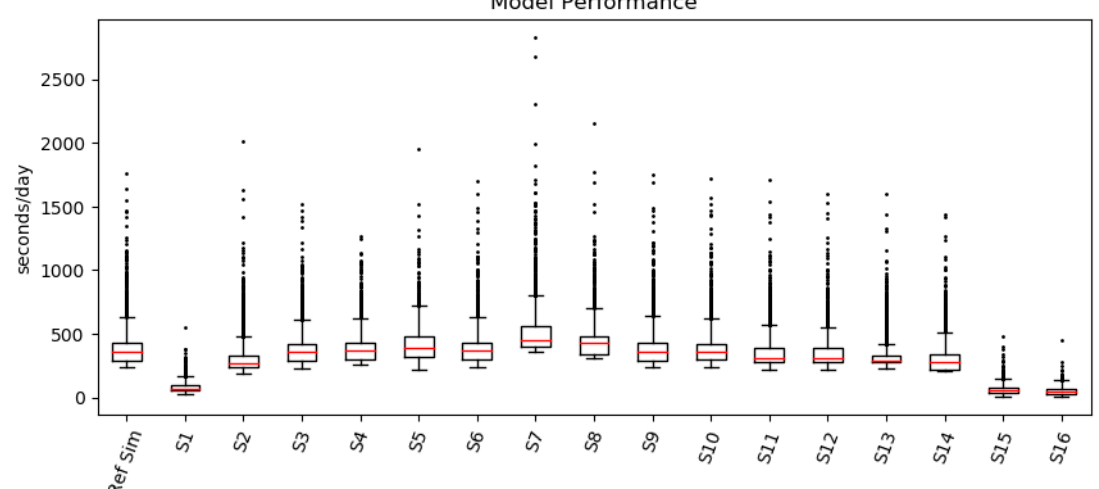
Figure 8. Boxplot graph with the computation time spent for each day of the simulation performed in the sensitivity analysis (Simulations: Ref Sim—reference simulation; 1—grid resolution; 2—elevation data; 3 and 4—cross-section widths and heights; 5 and 6—vertical and horizontal saturated hydraulic conductivities; 7 and 8—vertical soil discretization and soil depth; 9 and 10—surface and channel Manning coefficients; 11, 12, and 13—infiltration methods; 14, 15, and 16—porous media and vegetation processes (see Section 2.4 for details)). Table 6. Minimum, mean, and maximum computation times for each simulation test.